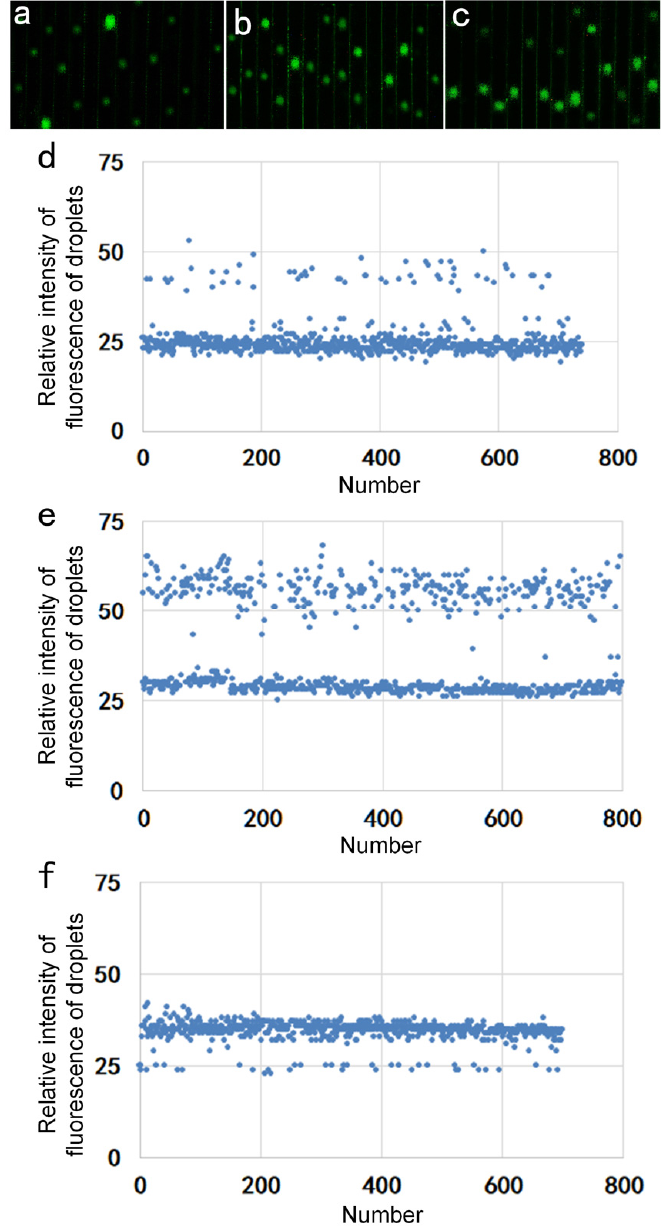
Figure 5. ( a ) Fluorescent image with a reagent concentration of 10 3 IU / mL. ( b ) Fluorescent image with a reagent concentration of 10 4 IU / mL. ( c ) Fluorescent image with a reagent concentration of 10 5 IU / mL. ( d ) Scatter plot of the brightness of the microdroplets with the concentration of 10 3 IU / mL. ( e ) Scatter plot of the brightness of the microdroplets with the concentration of 10 4 IU / mL. ( f ) Scatter plot of the brightness of the microdroplets with the concentration of 10 5 IU / mL.